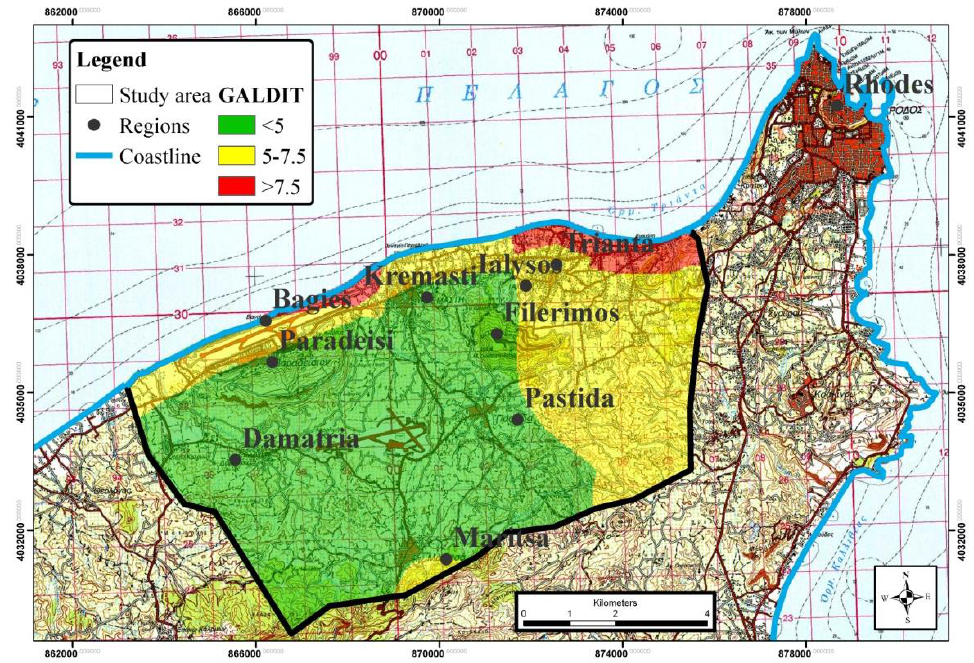
Table 3. Distribution of the vulnerability class areas (%) according to GALDIT.